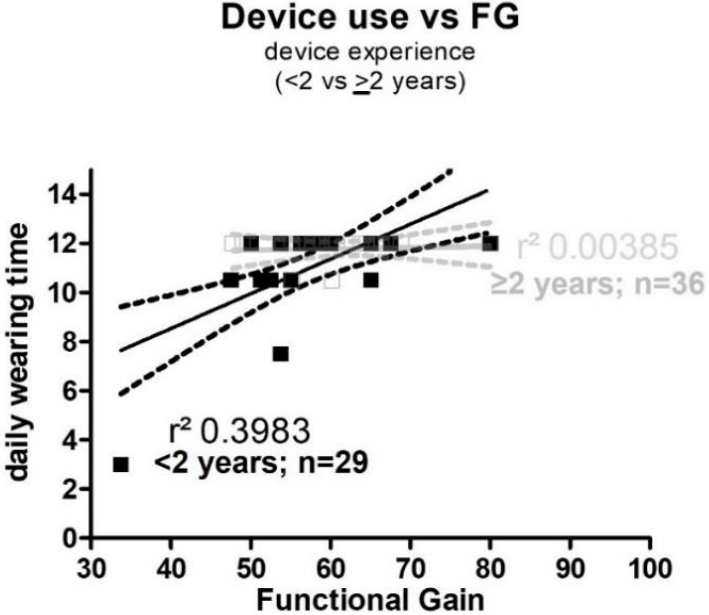
Figure 2. Scatter plot correlation functional gain (FG) vs. daily device use. The scatter plots and the corresponding linear regression (full line) and its upper and lower confidence interval (dotted line) shows the correlation between the mean functional gain (FG) average and the daily device use in hours. In dark squares are the individuals with a device experience of less than two years (<2) and the gray open squares represent the children with a device experience of 2 years or more ( ≥ 2). The correlation coefficient r 2 was 0.3983 for the group <2 years (slight correlation) versus and r 2 of 0.00385 for the group of ≥ 2 years (no correlation).